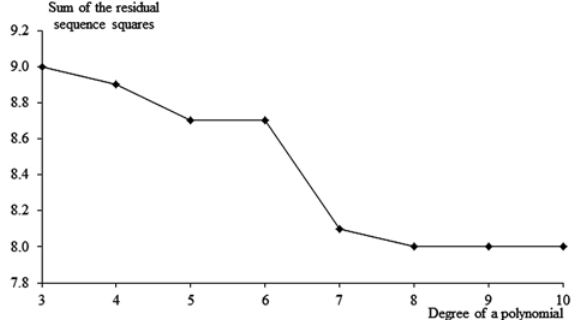
Fig. 3. Dependence of the sum of the squares of the residual sequence on the degree of a polynomial.